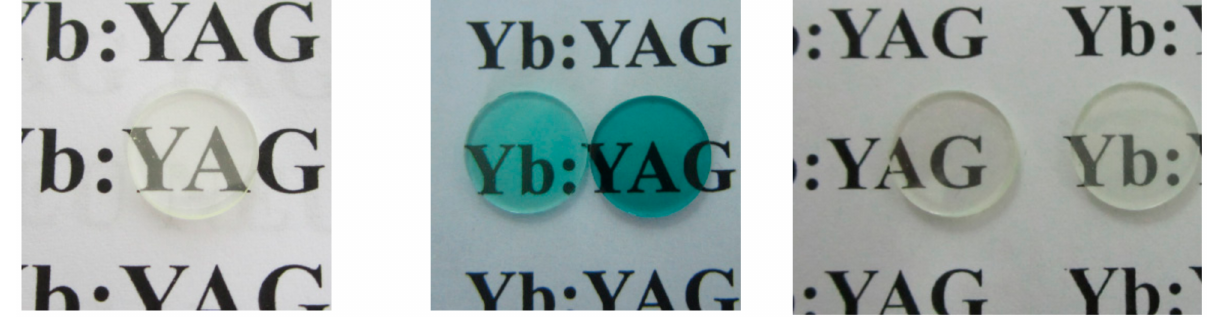
Figure 8. Photos of (Y 1 − x Yb x )AG transparent ceramics (1.2 mm thick), from left to right: x = 0, 0.01 and 0.1, before annealing and x = 0, 0.01 and 0.1, after annealing.